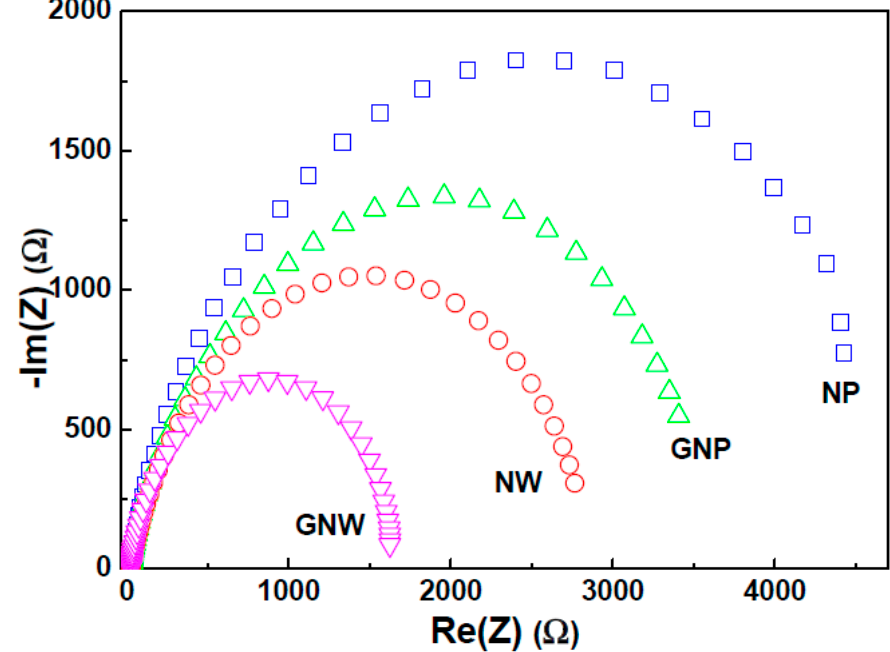
Figure 19. EIS plots of TiO 2 nanoparticles (NP), TiO 2 nanoparticles/G (GNP), TiO 2 nanowires (NW), and TiO 2 nanowires/G (GNW). Reprinted from reference [92].